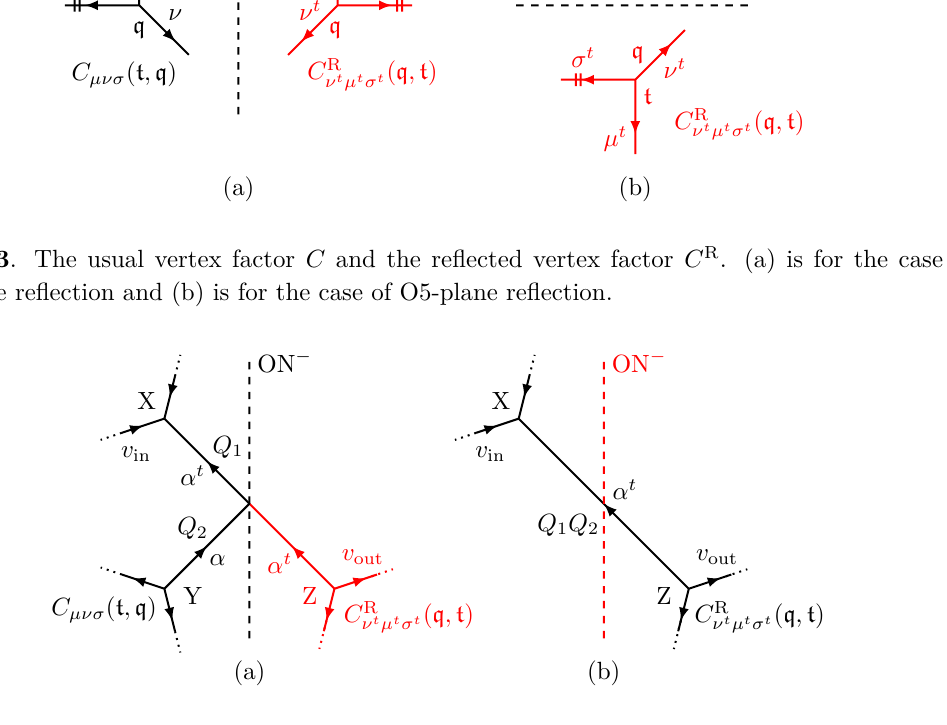
Figure 4 . Reflection of the brane α by the